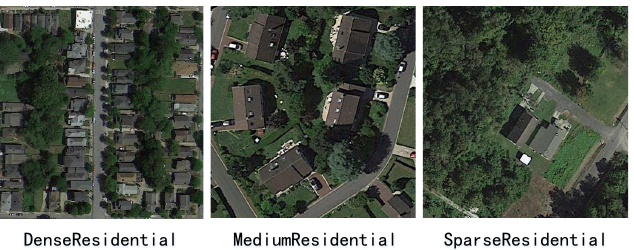
Figure 3. Different categories of images composed of two modalities (houses and trees) from the AID dataset